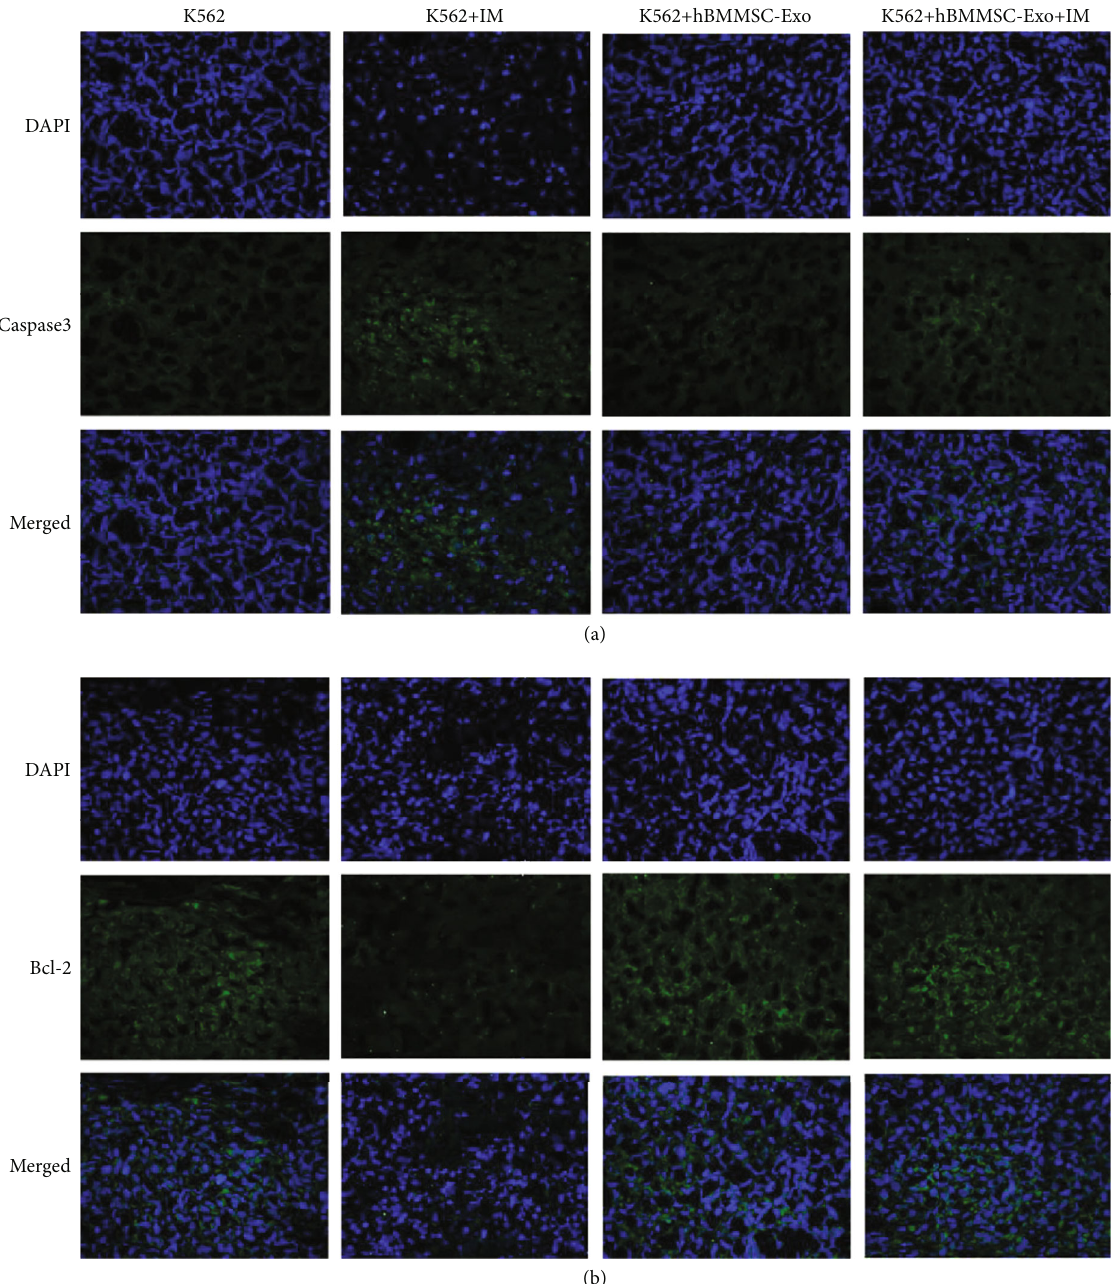
Figure 7: Expression of Caspase3 and Bcl-2 was con fi rmed by the immuno fl uorenscence staining in tumor tissues. Nuclei were stained using DAPI. (a) Expression of Caspase3 in tumor tissues by the immuno fl uorenscence staining. (b) Expression of Bcl-2 in tumor tissue by the immuno fl uorenscence staining. The data were expressed as the mean ± SD of three independent experiments. ∗ p < 0 : 05 Student ’ s t